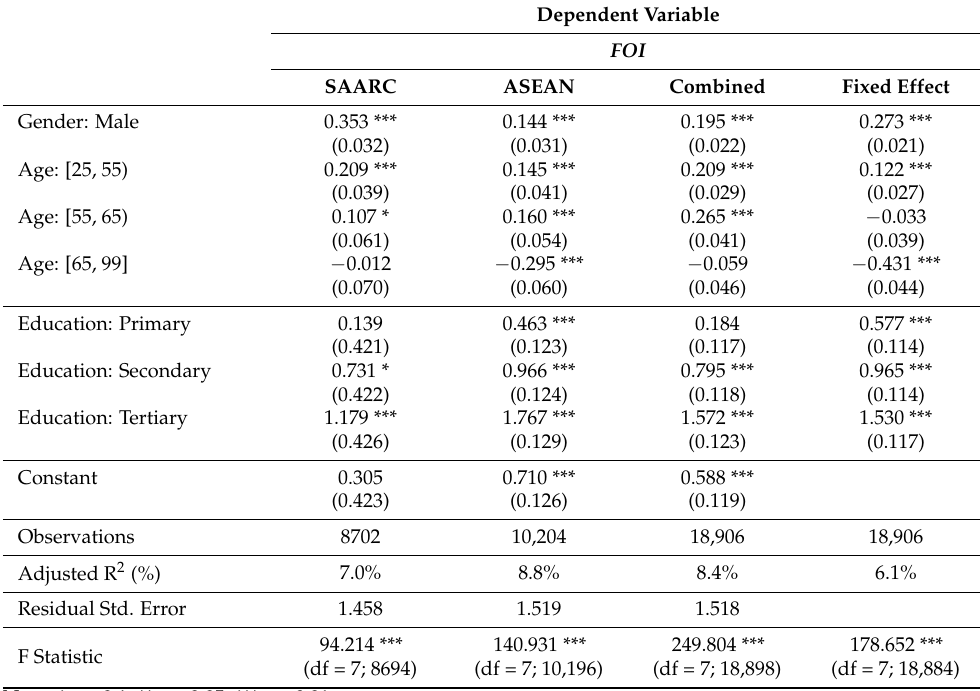
Table 5. Regression outcomes for SAARC, ASEAN, and combined-data (Equation (1)), and fixed-effect models (Equation